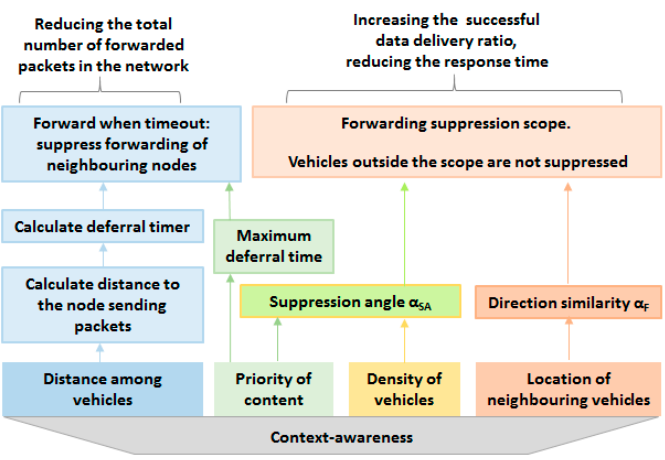
Figure 1. Context-aware packet-forwarding method.